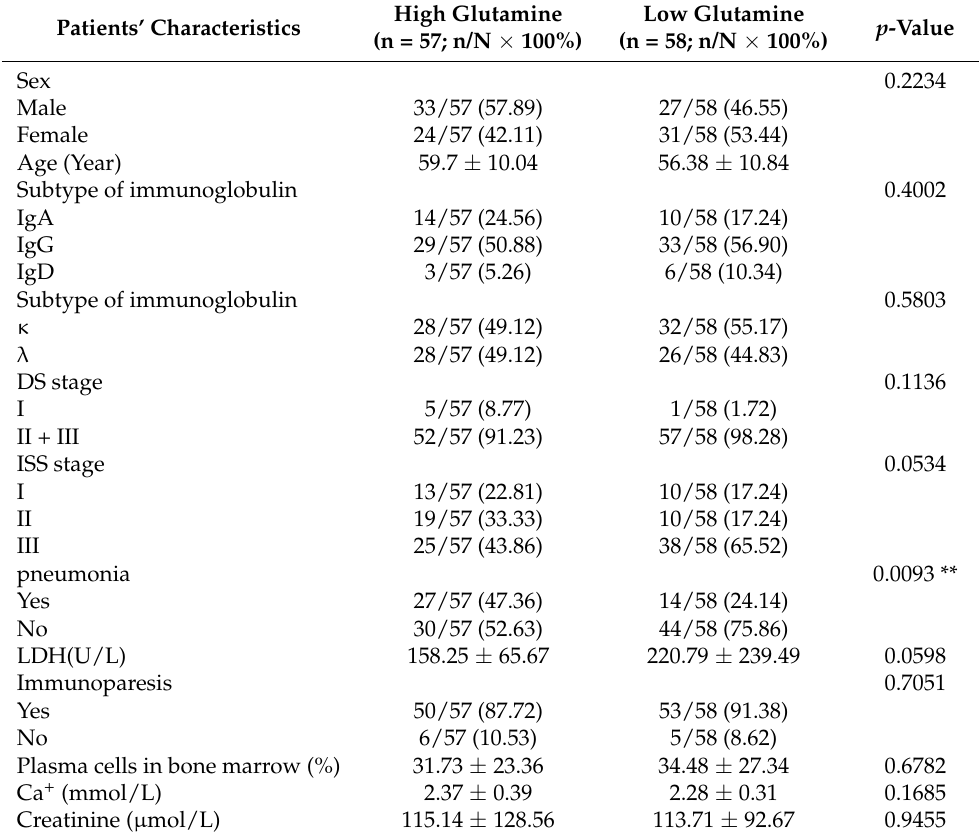
Table 2. The correlation between glutamine concentration and clinical characteristics of newly diagnosed MM